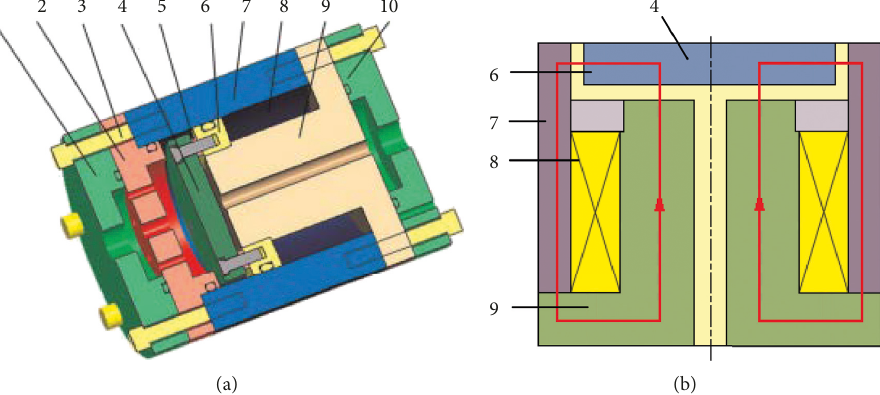
Figure 39: (a) Configuration of the MR valve. (b) The simplified magnetic circuit of the proposed MR valve.1, left head cover; 2, flow-guided plate; 3, screw; 4, magnetic plate; 5, washer; 6, fixed plate; 7, valve body; 8, excitation coil; 9, valve core; 10 right head cover [99].